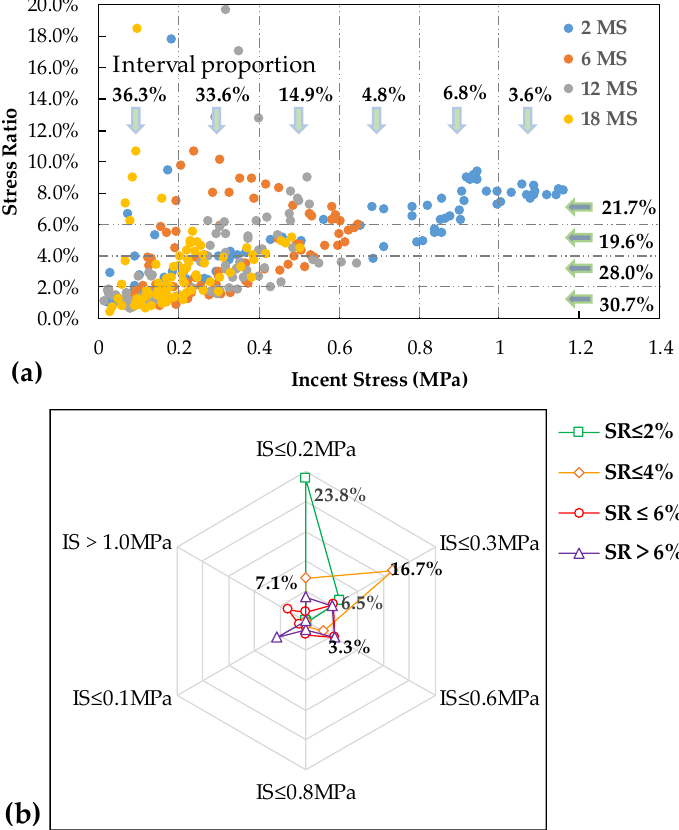
Figure 11. Distribution characteristics of the stress ratio: ( a ) stress ratio data points distribution under different incident stresses; ( b ) statistical distribution of the stress ratio interval under different incident stresses.